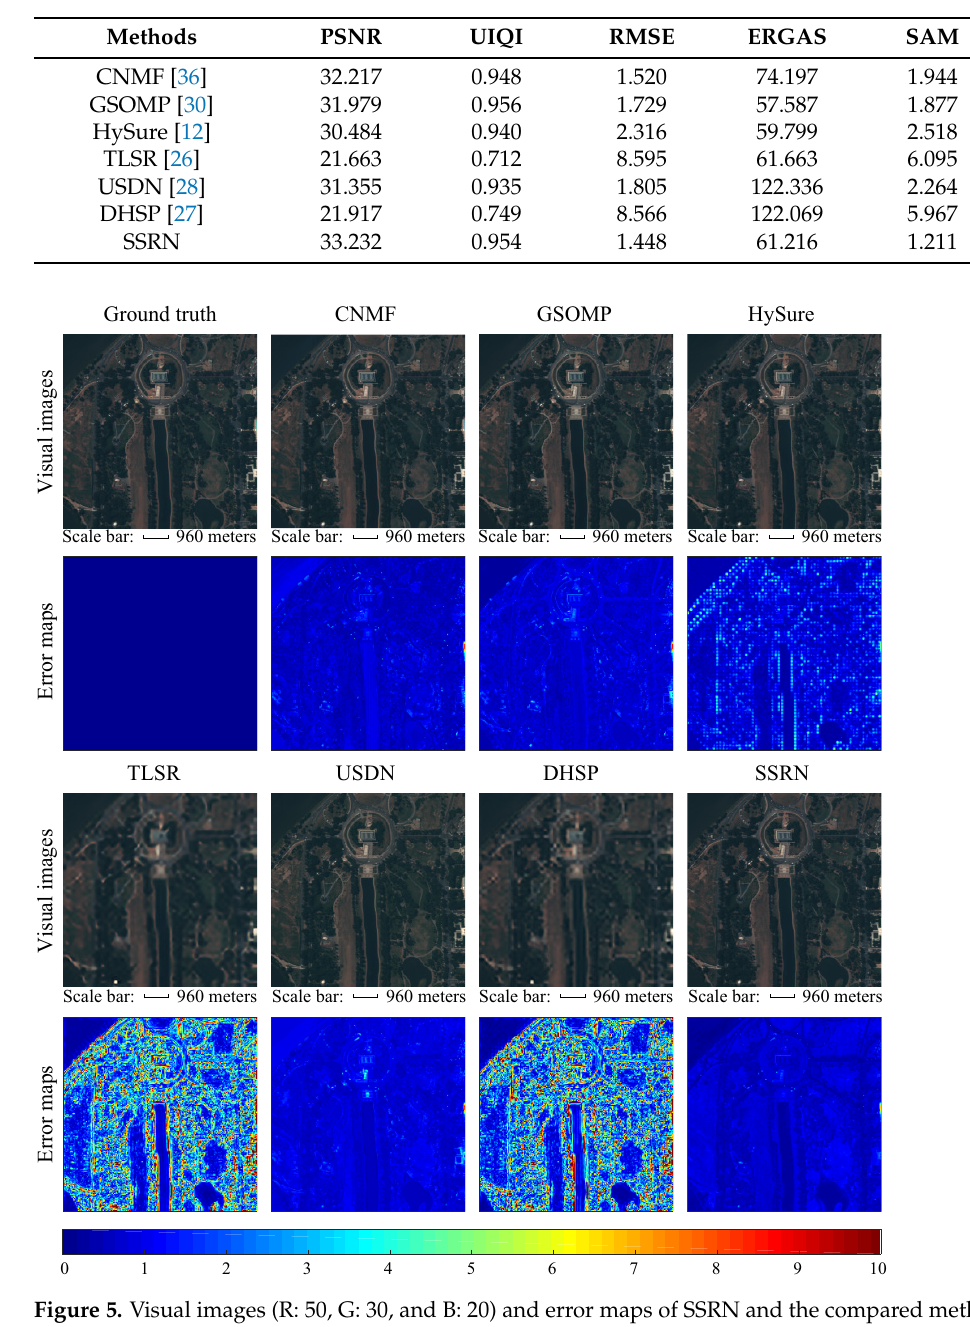
Table 6. Quantitative experimental results on the WDCM database.